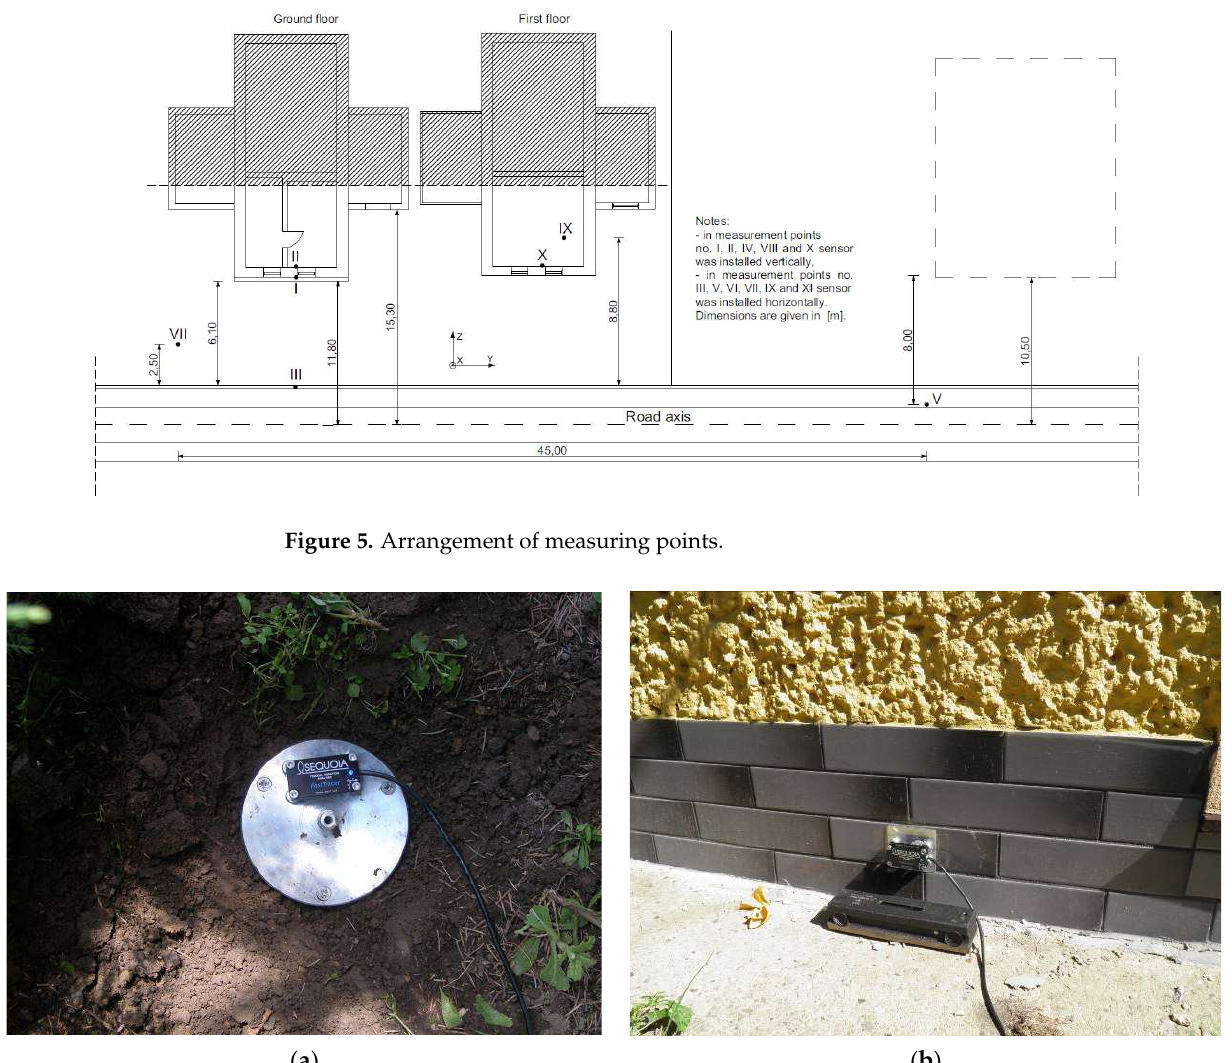
Figure 5. Arrangement of measuring points.